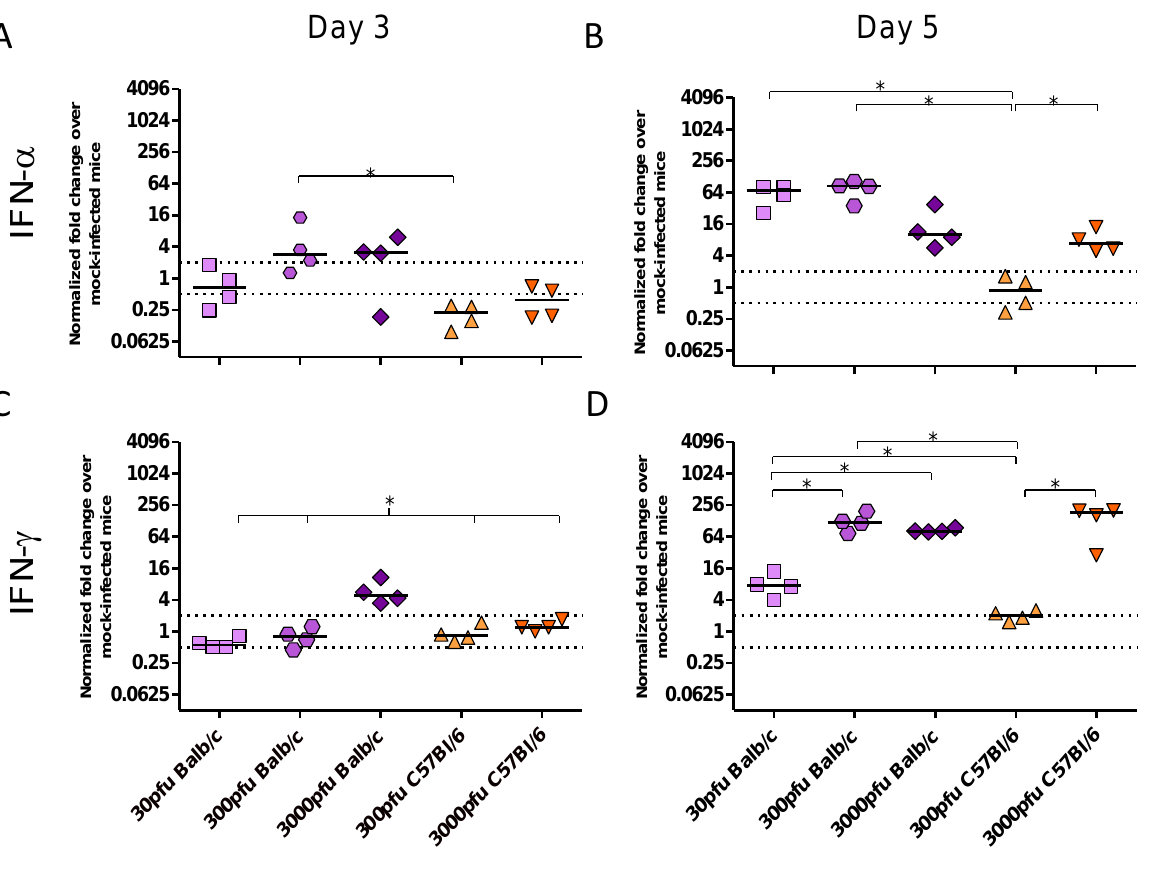
Figure 3. Cytokine expression by Balb/c and C57Bl/6 mice following infection with PVM 15. Five to six week-old Balb/c and C57Bl/6 mice were inoculated with medium, 30 pfu, 300 pfu, or 3000 pfu of PVM 15 and lungs were collected from four mice per group on days 3 ( A and C ) and 5 p.i. ( B and D ). Expression levels of IFN-α ( A and B ) and IFN-γ ( C and D ) transcripts were calculated using the Bio-Rad analysis software (Bio-Rad CFX Manager Version 2.0), normalized against the expression of both β-actin and GAPDH housekeeping genes, and expressed as the normalized fold-change over mock-infected control animals euthanized on the same day p.i.. Each data point represents a single animal and the line represents the group median. *, p